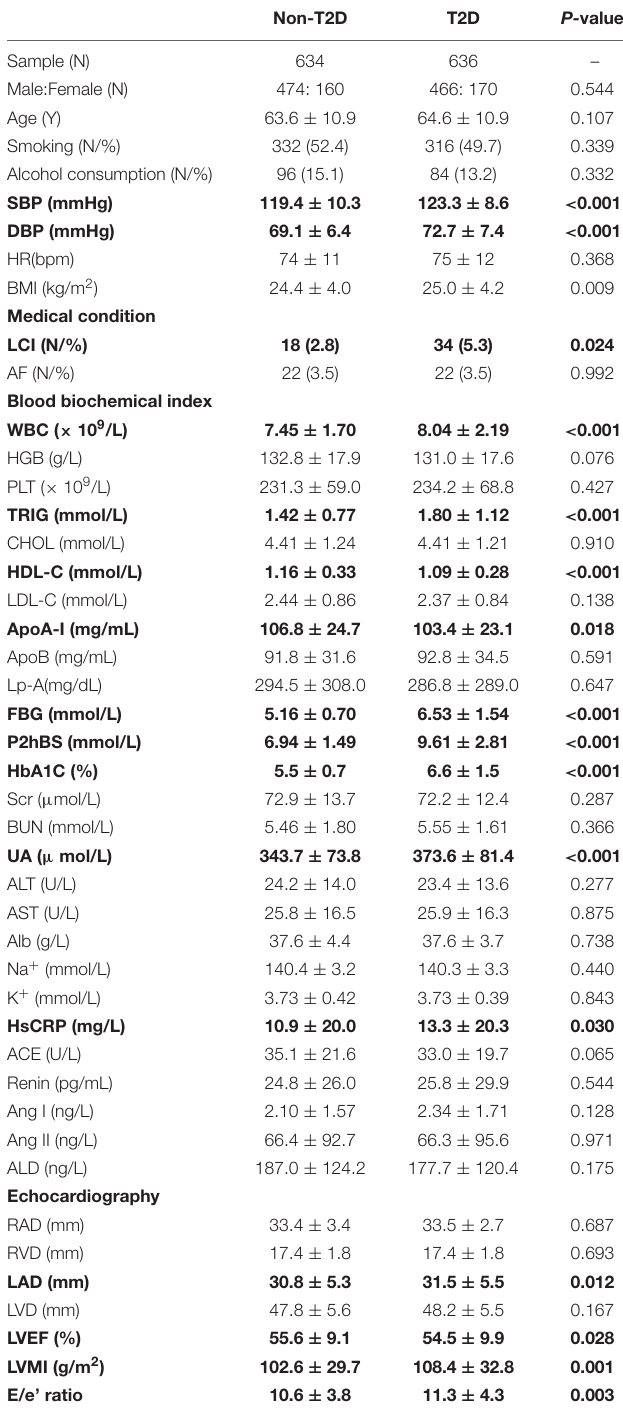
TABLE 1 | Baseline characteristics of the study